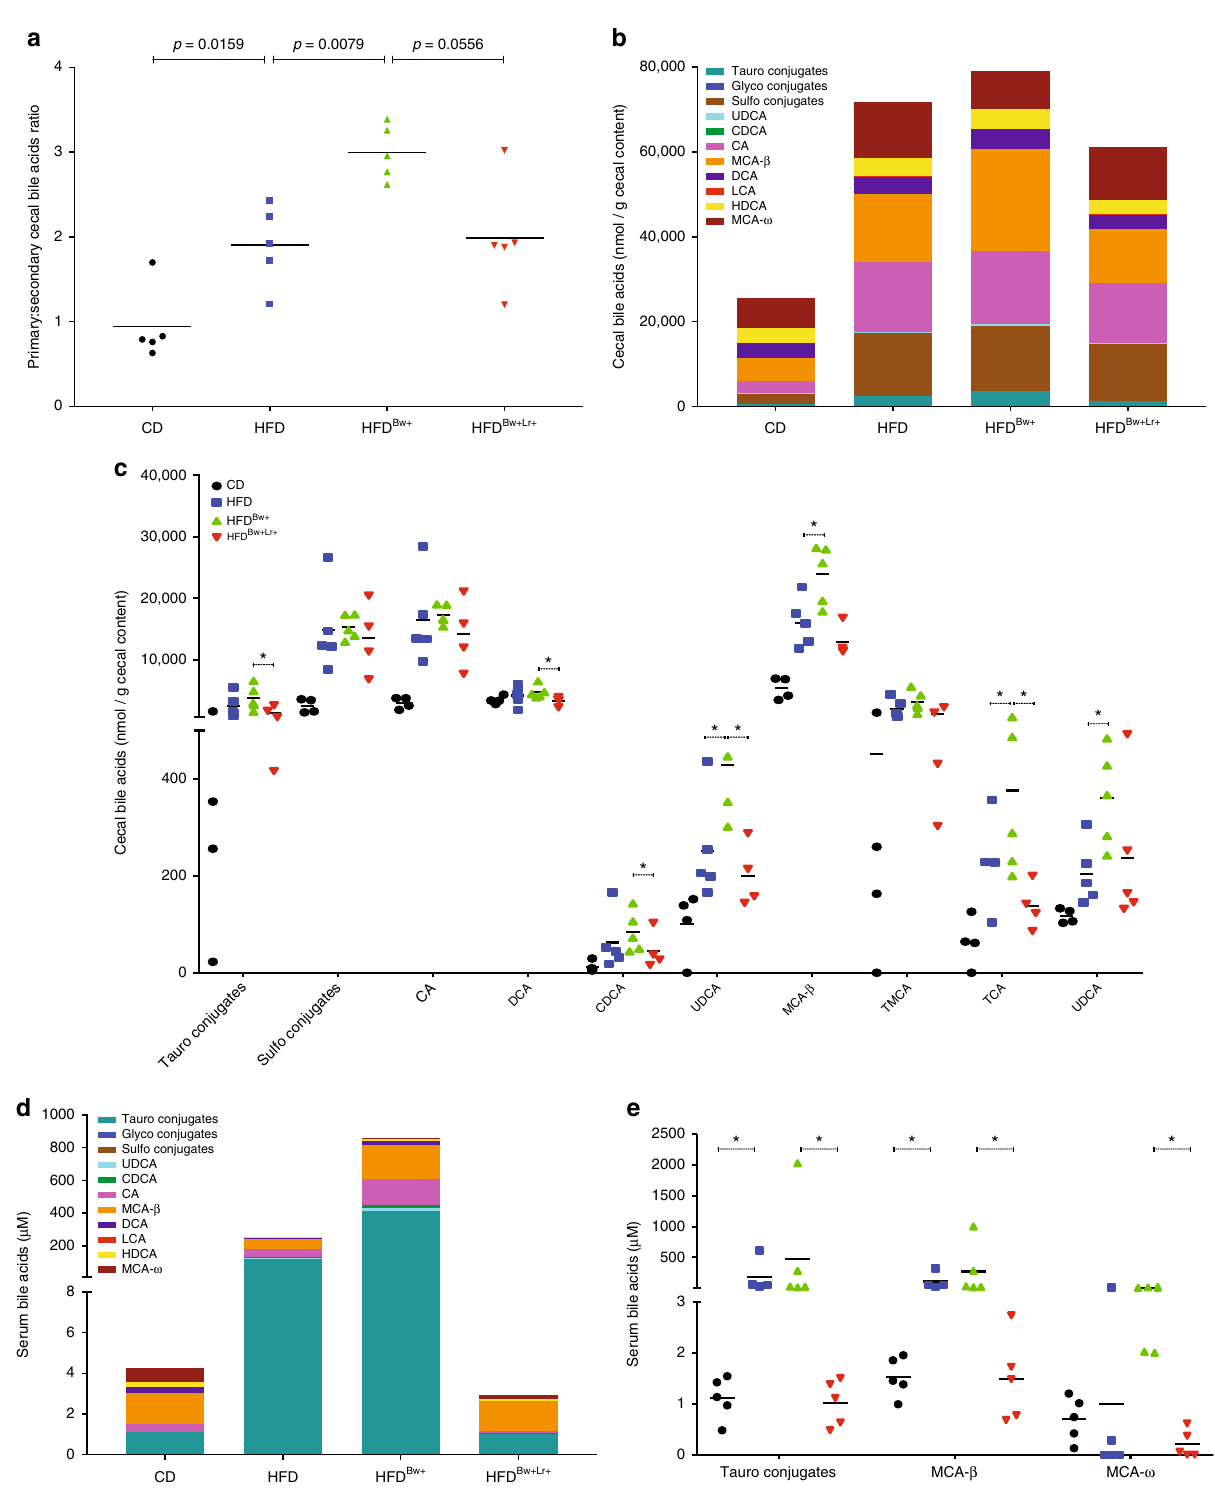
Fig. 6 B. wadsworthia worsens HFD-induced bile acid dysmetabolism. a Ratio of primary to secondary bile acids in caecum. b Stacked bar showing the bile acids concentration in the caecum. c Concentration of difference bile acids in the caecum. (* p < 0.05 vs. HFD, + p < 0.05 vs. HFD Bw + ; n = 5 – 6/group). d Stacked bar showing the bile acids concentration in the serum. e Concentration of difference bile acids in the serum (* p < 0.05, ** p < 0.05; n = 5 – 6/group). Statistical comparison was performed by fi rst testing normality using Kolmogorov – Smirnov test and then ANOVA or Kruskal – Wallis test with Bonferroni or Dunn ’ s post hoc test. Error bars represents